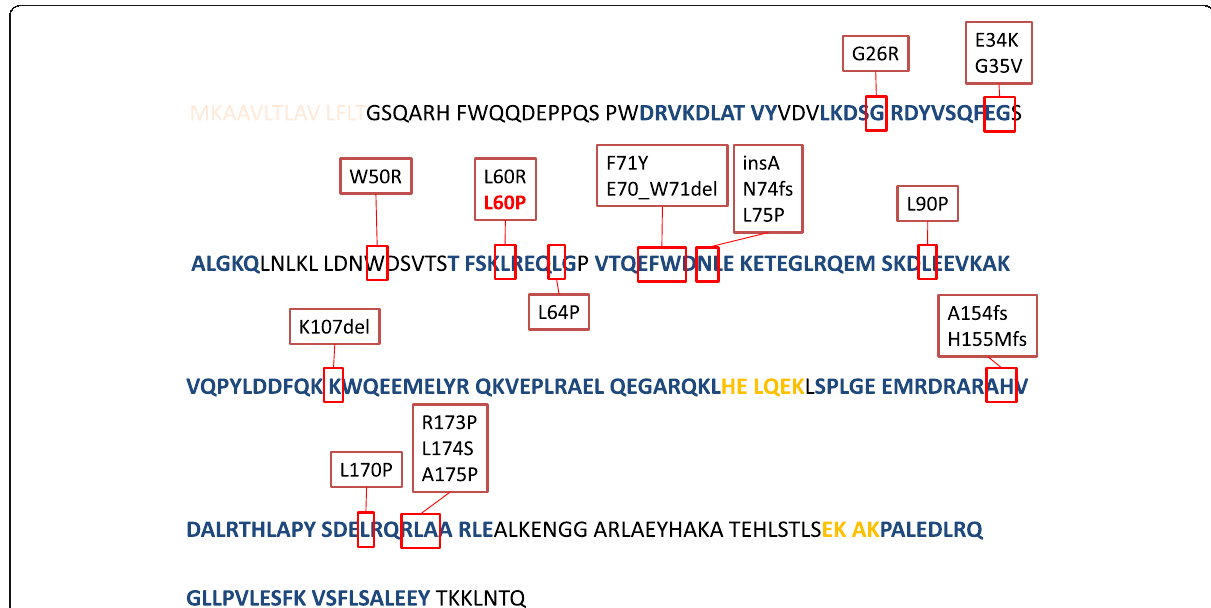
Fig. 1 Secondary structure of ApoAI, based on the UNIPROT database (https://www.uniprot.org/uniprot/P02647). Helix is depicted with bold blue letters and turn region with orange bold. The sites of identified mutations, as provided by http://www.amyloidosismutations.com/cdna- aapoai.html are shown with red boxes. The L60P mutation described in the manuscript is also shown in red